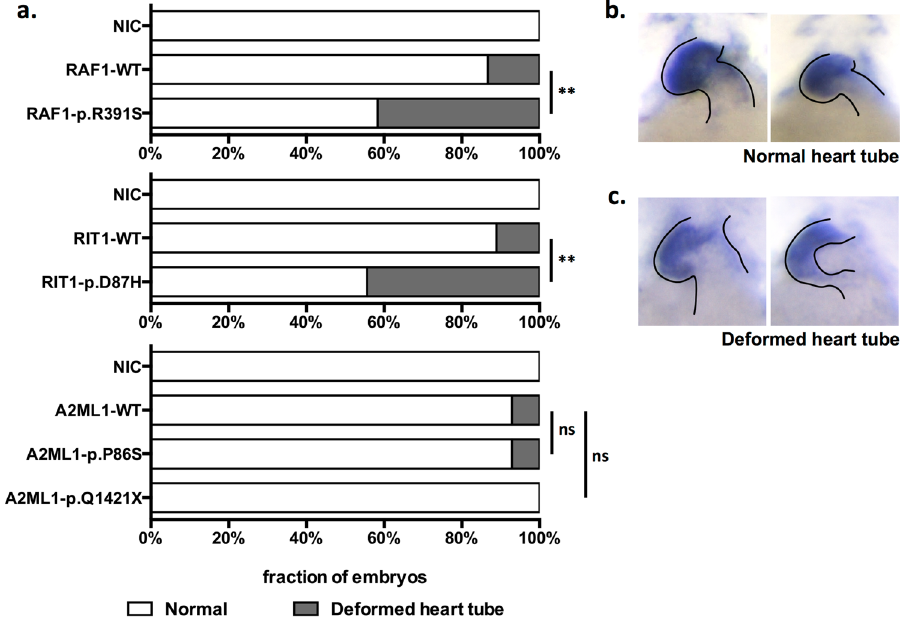
Figure 5. Structural assessment of cardiac tubes by in situ hybridization of cmlc1 . Statistical significance was derived using a two-sided Fisher’s exact test to compare mutants with the corresponding WT. ** p < 0.01; ns: not significant. ( a ) The proportion of zebrafish embryos with a normal or deformed heart tube structure. ( b ) Representative embryos with a normal and ( c ) deformed heart